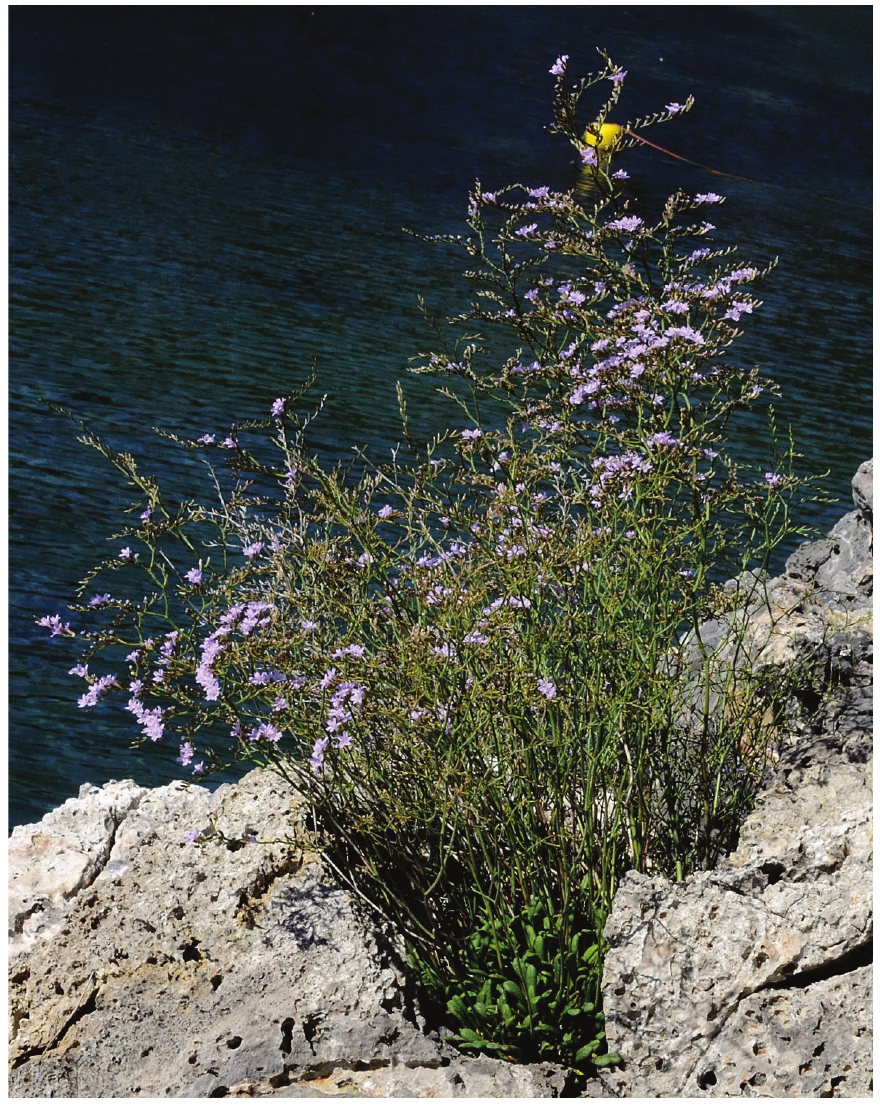
Figure 7. Limonium multiforme Pignatti in Calafuria cliffs, near Livorno (Tuscany). Photograph by D.